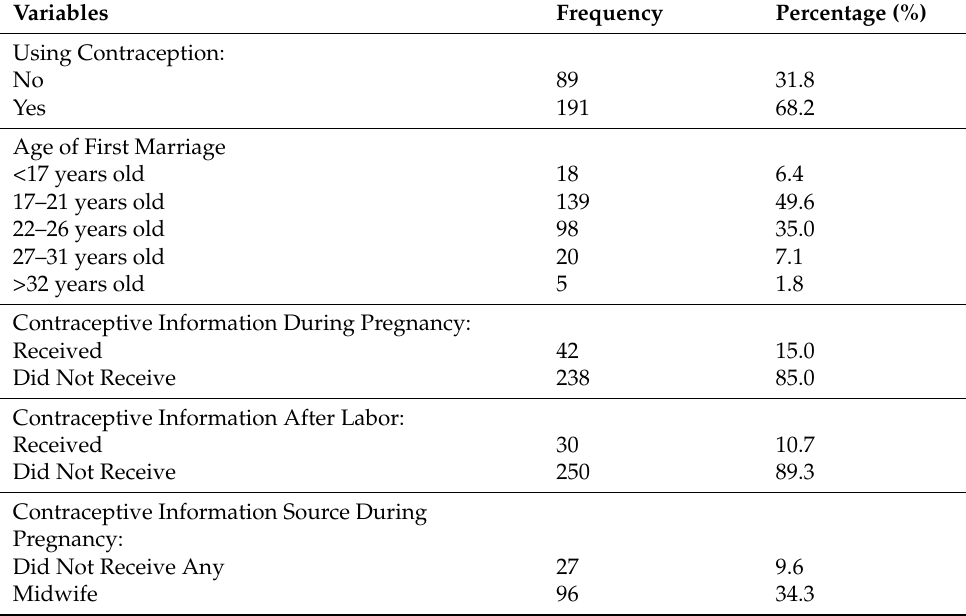
Table 1. Frequency distribution of marriage age, information during pregnancy, information during labor, information source, counselling, reason for not taking contraception, types of contraception, and places (n =